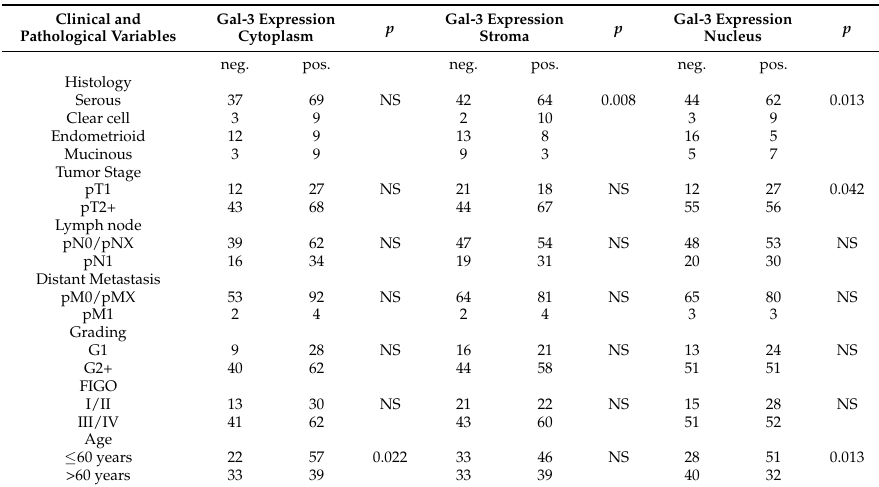
Table 3. Gal-3 staining correlated with clinical and pathological